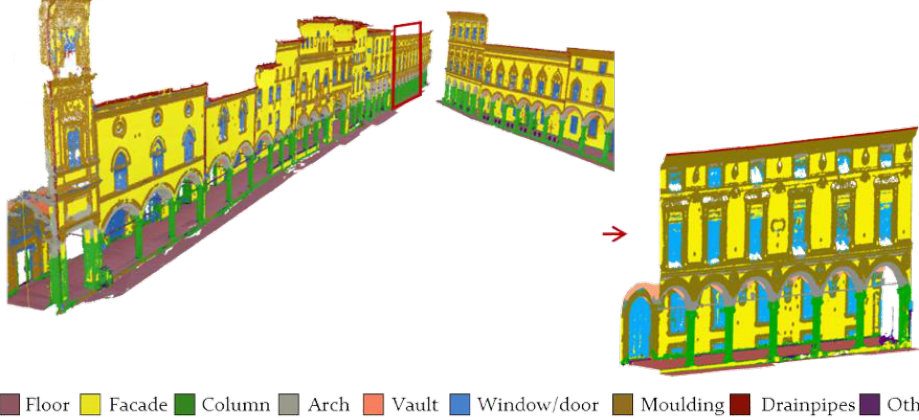
Figure 8. Classification results: generalisation level #1, within dataset A.